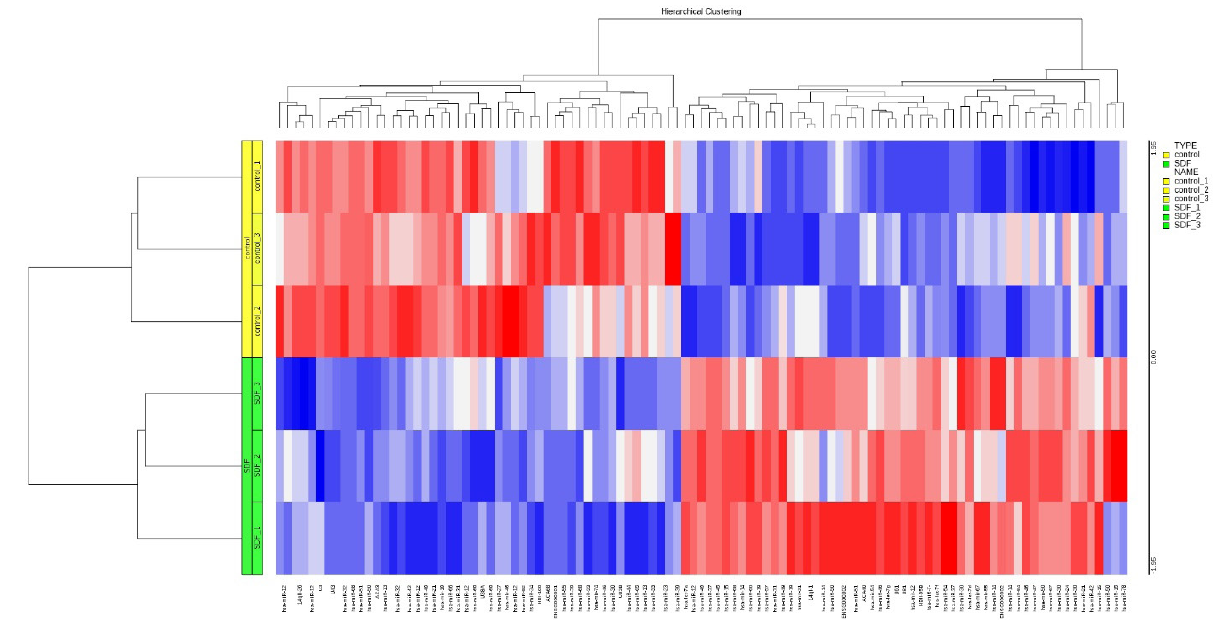
Figure 1: Hierarchical clustered heat map depicting miRNA expression in SDF-1 treated human BMSCs versus control ( n = 3 each group). Differential expression pattern is observed between the miRNAs of the two groups.